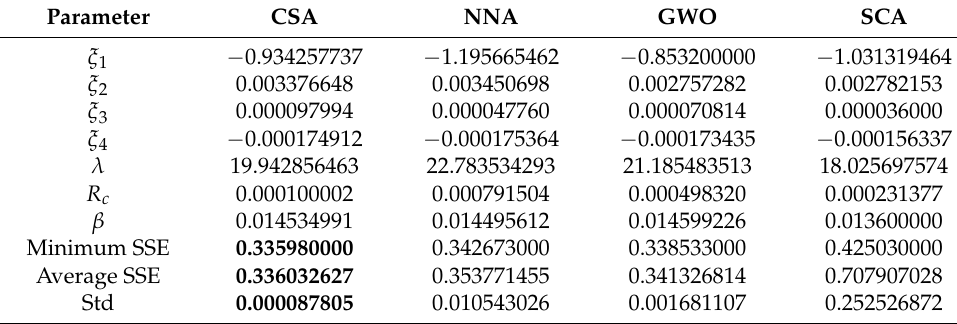
Figure 13. Convergence curve of fitness function for 250 W fuel cell. Table 4. Optimal parameters of 250 W PEMFC model.